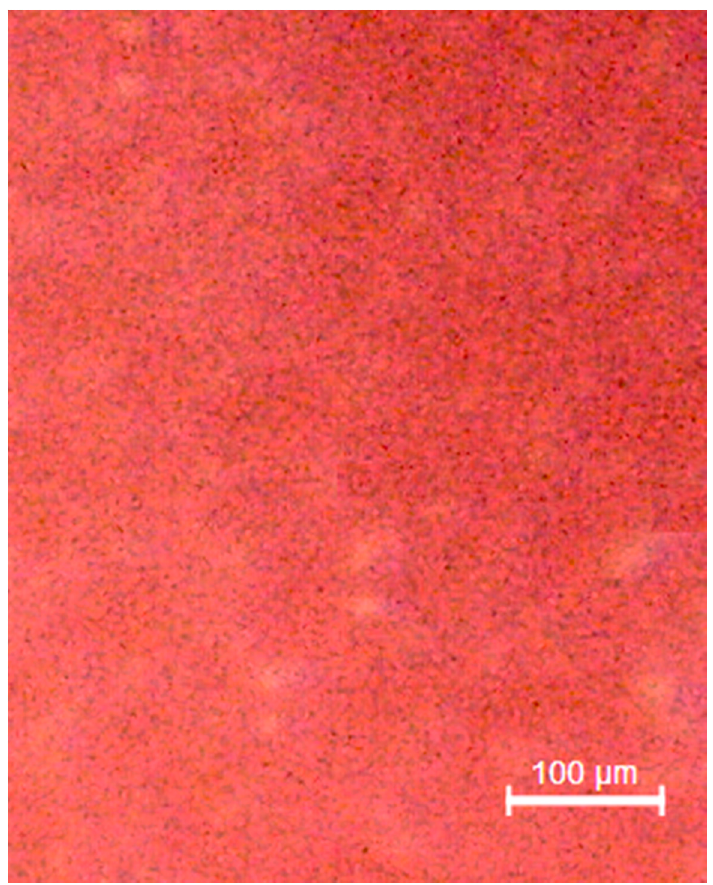
Figure 4. Resin fracture surface observation in stereomicroscopy (Leica ® M125 C). It shows fracture lines on a uniform surface.